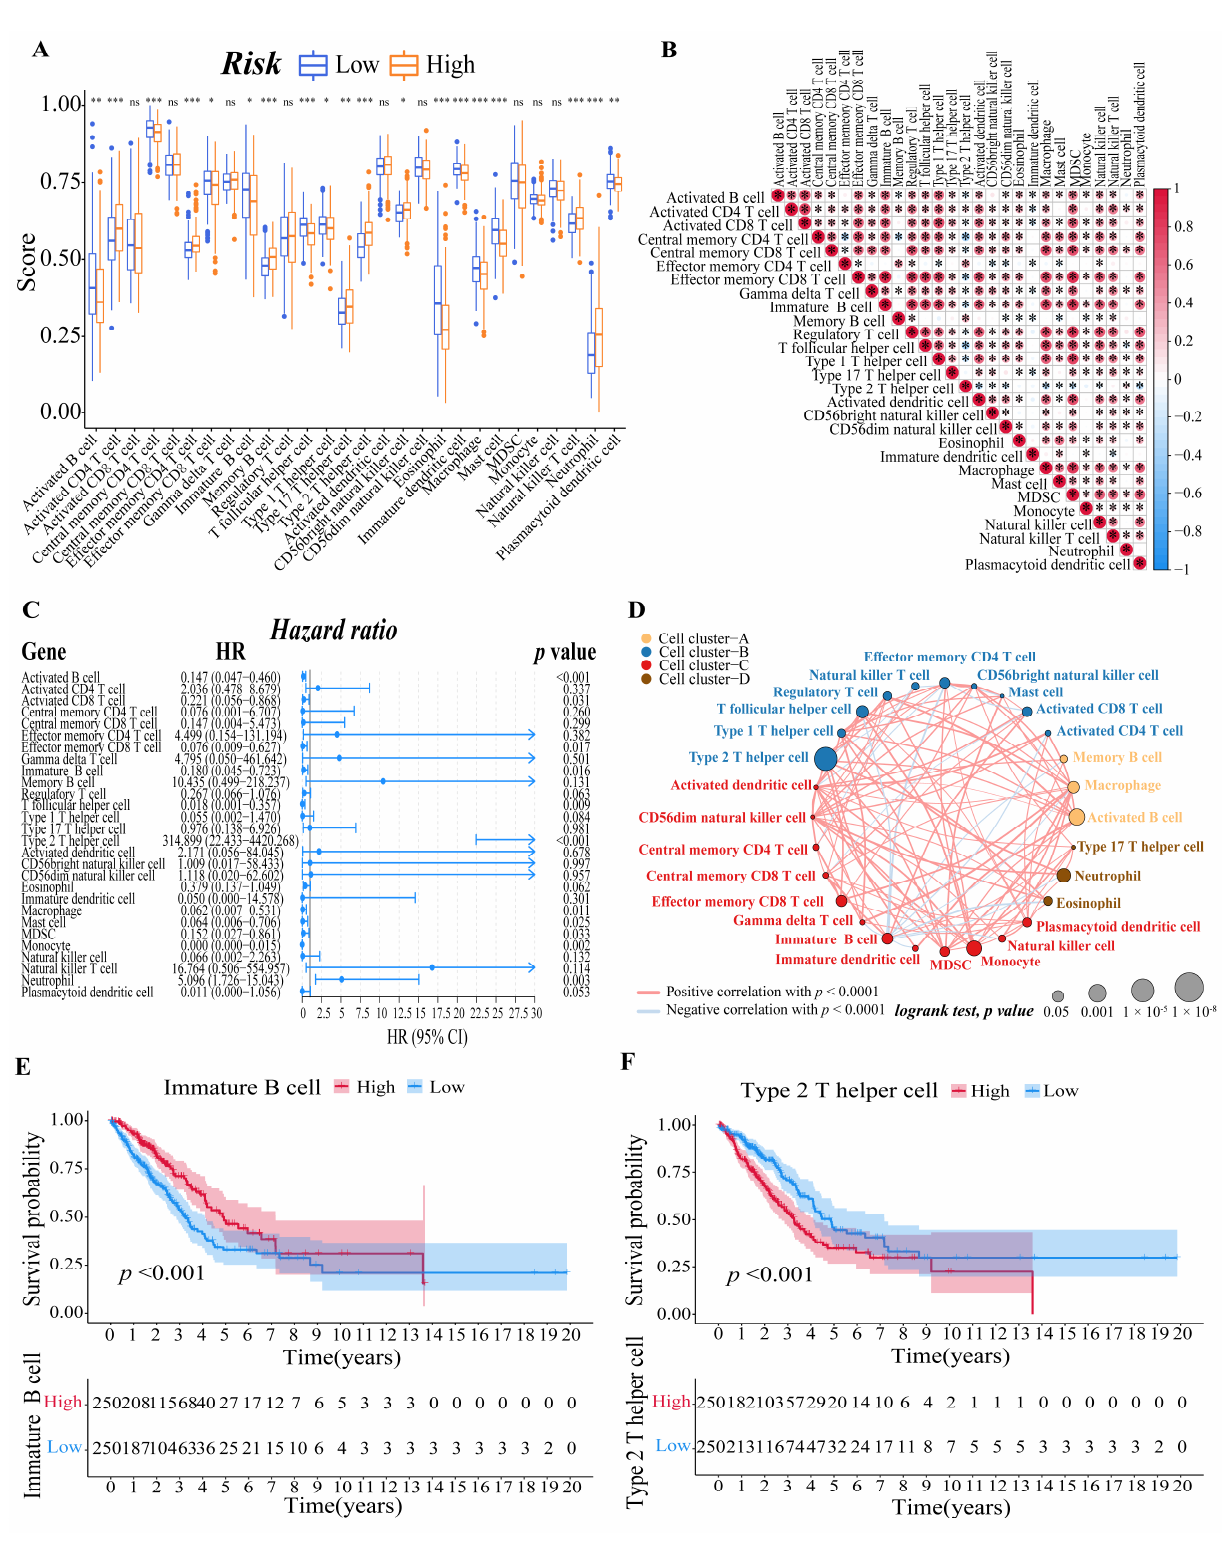
Figure 6. Evaluation of immune microenvironment of LUAD patients. ( A ) Boxplots to display the enrichment scores of 28 immune cells of different risk groups in the training cohort. A value of p < 0.05 indicates a statistically significant difference, * indicates p < 0.05; ** indicates p < 0.01; *** indi- cates p < 0.001. ( B ) Correlation diagram between every two immune cells. The size of the circle and